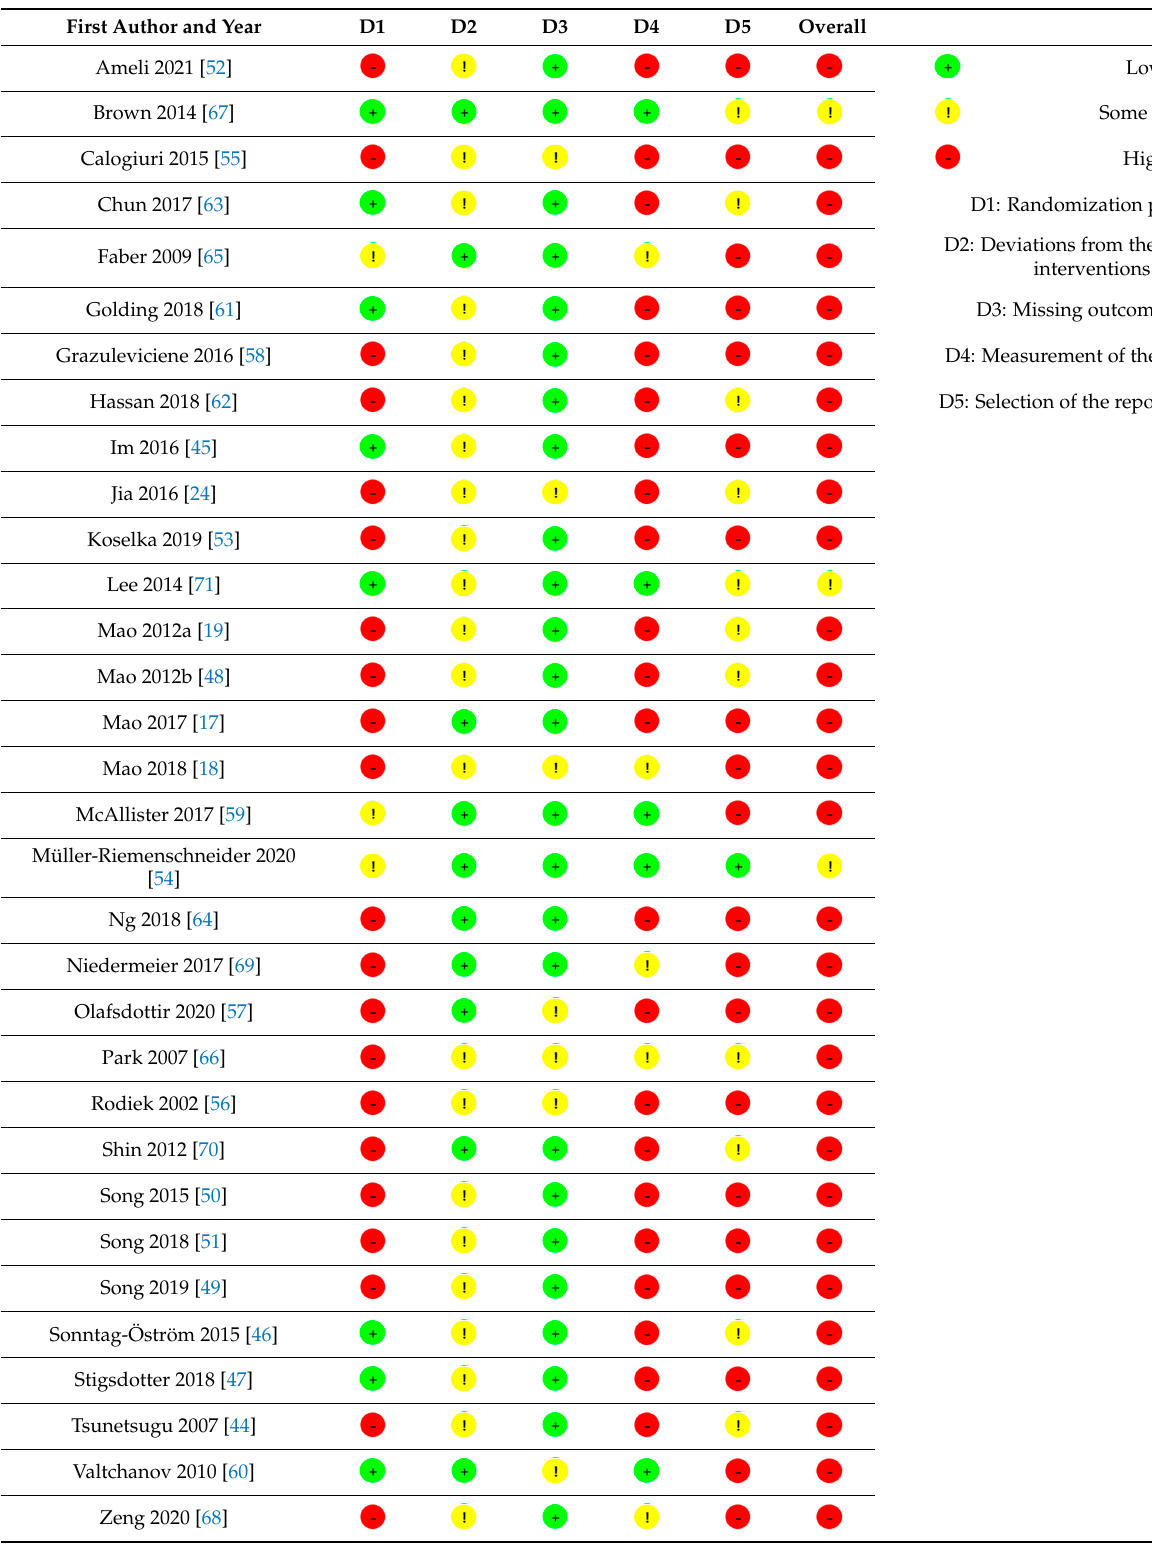
Table 5. Risk of bias of randomized controlled trials and cross-over trials using the RoB 2 tool.